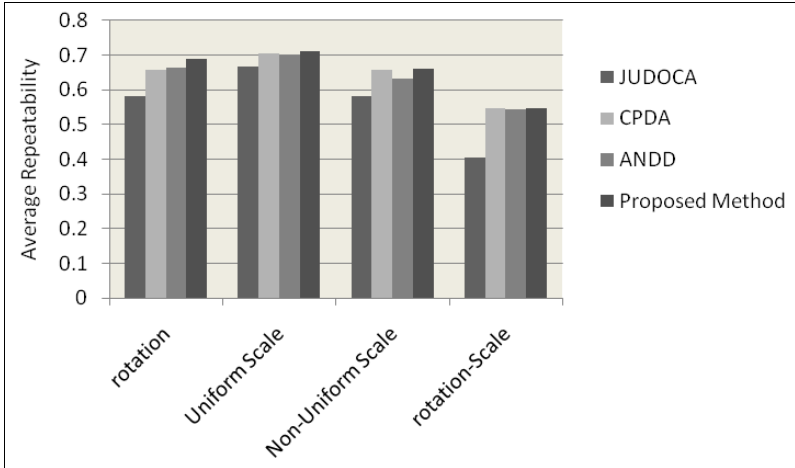
Figure 10. Average repeatability under rotation, uniform scale change, non-uniform scale change, and the combined rotation and scale effect of the different